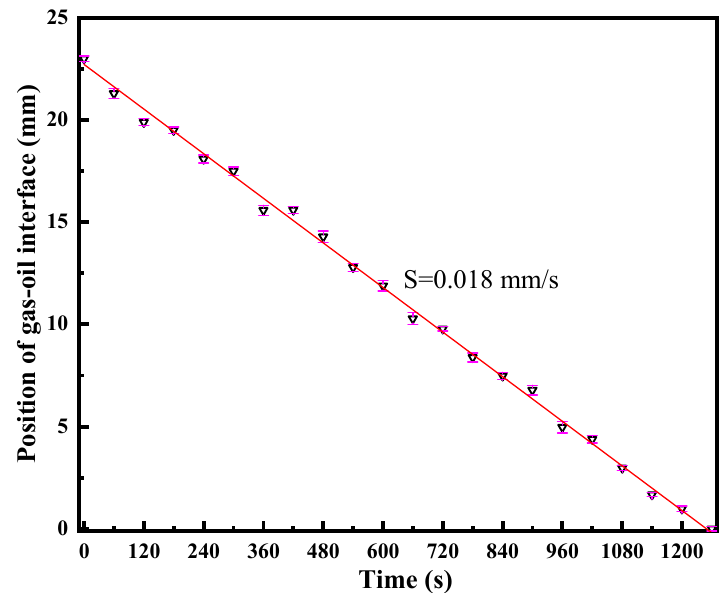
Figure 9. Graph depicting the position of the GOI around well T401 with time.